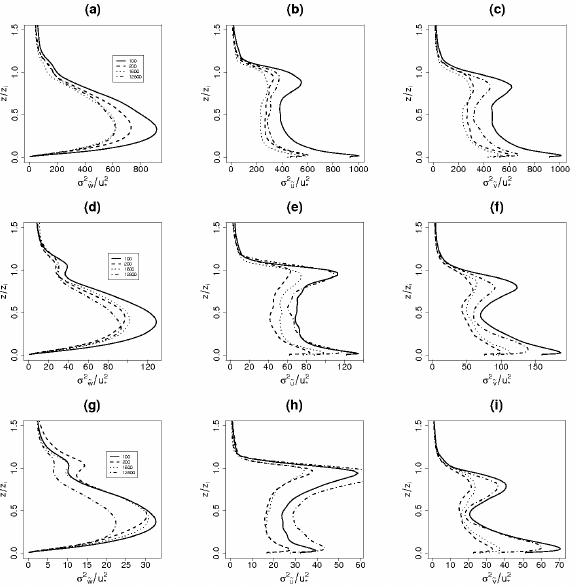
Fig. 13. Spatial variances of scalars (a) vertical wind [(m s − 1 ) 2 ] (b) temperature [K] (c) specific humidity [(g kg − 1 ) 2 ] (d) horizon- tal wind speed [(m s − 1 ) 2 ] for (top) low, (middle) intermediate and (bottom) high wind speeds